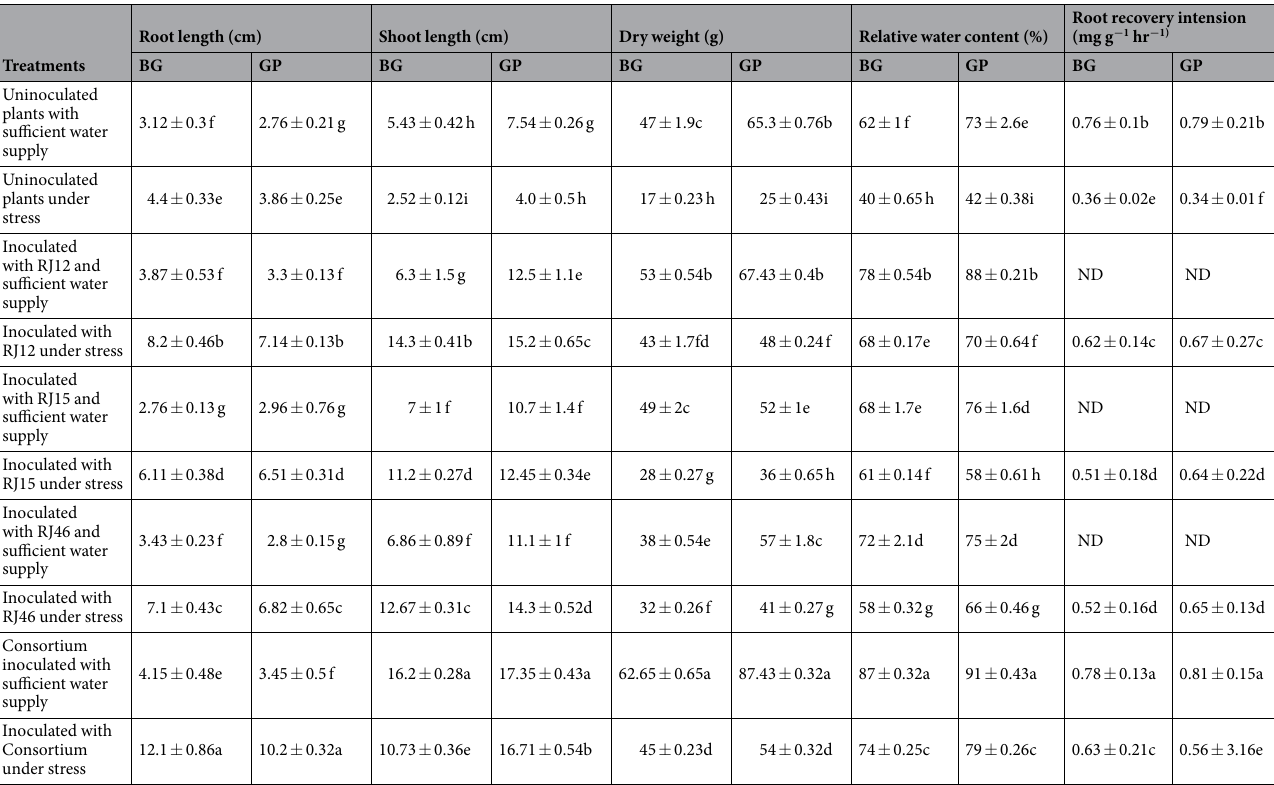
Table 3. Effect of bacteria inoculation on plant growth promotion in black gram and garden pea plants (RJ12 - Ochrobactrum pseudogrignonense, RJ15 - Pseudomonas sp, RJ46 - Bacillus subtilis. Consortium is the mixture of all the three strains in equal ratio (1:1:1). Two-way ANOVA was performed considering water supply and bacteria inoculation as two independent variables, followed by Tukey’s post-test for each treatment. For each figure in a column, values represented by the same lowercase letters are not significantly different at p = 0.05.; figures are means ± standard deviation (n = 5). Table key: BG - black gram, GP - garden pea, ND – not